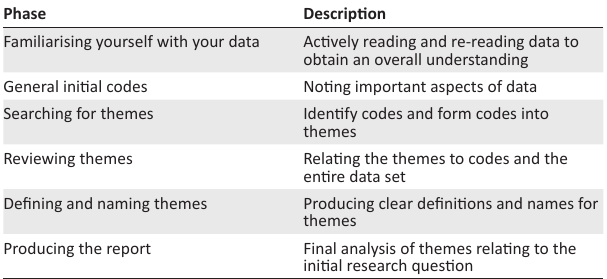
TABLE 2: Phases of thematic